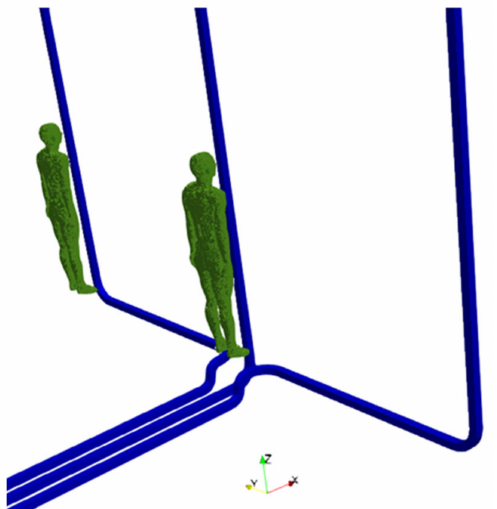
Figure 3. Two considered positions of the human body with reference to the exposure scenario C.1, with the human body close to the central (C.1a) or lateral (C.1b) phase conductor. The traces of the conductors are also reported in the